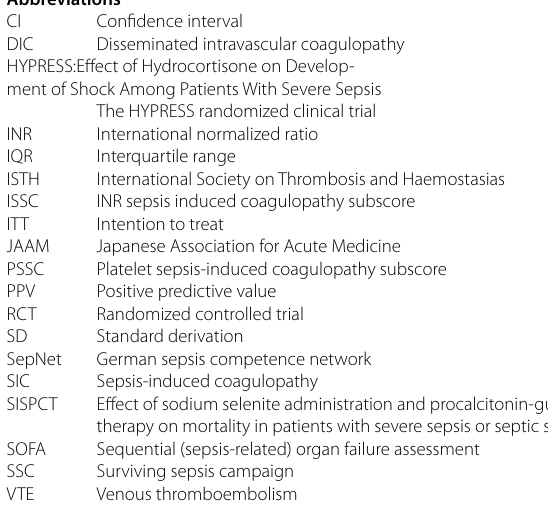
Table S6 Maximum platelet SIC subscore after onset grouped by platelet SIC subscore at onset. Table S7. Part 1: Sepsis onset characteristics of SISPCT patients [6] grouped by